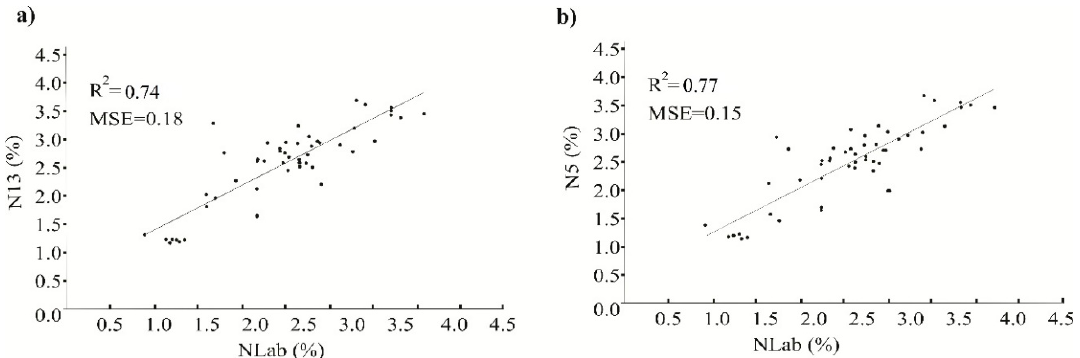
Figure 5. RF prediction for Nt; ( a ) prediction using thirteen indices in the model; ( b ) prediction using five indices in the model.